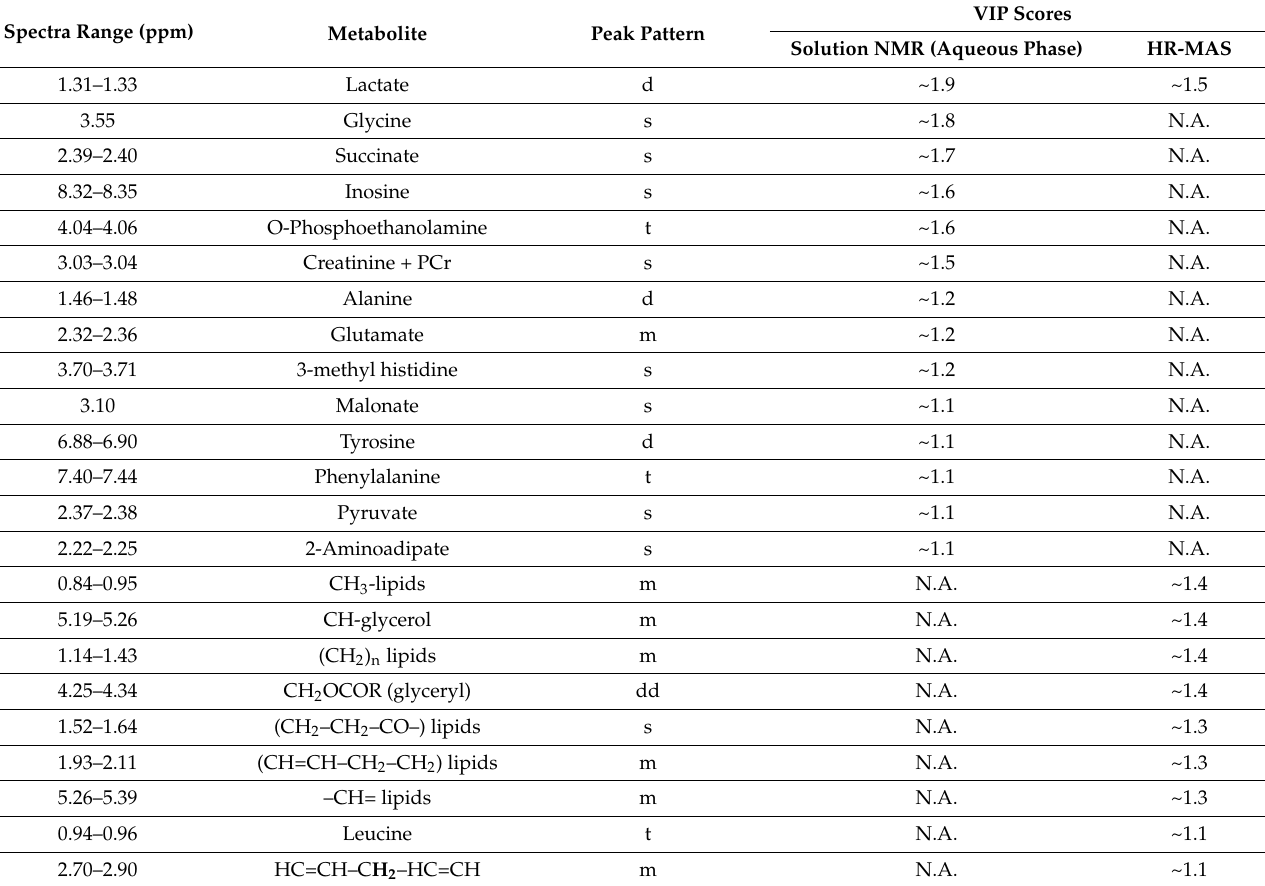
Table 2. A variable important in projection (VIP) scores obtained from partial least square discriminant analysis (PLS-DA) for metabolites from aqueous phase and HR-MAS analyses. Spectra Range